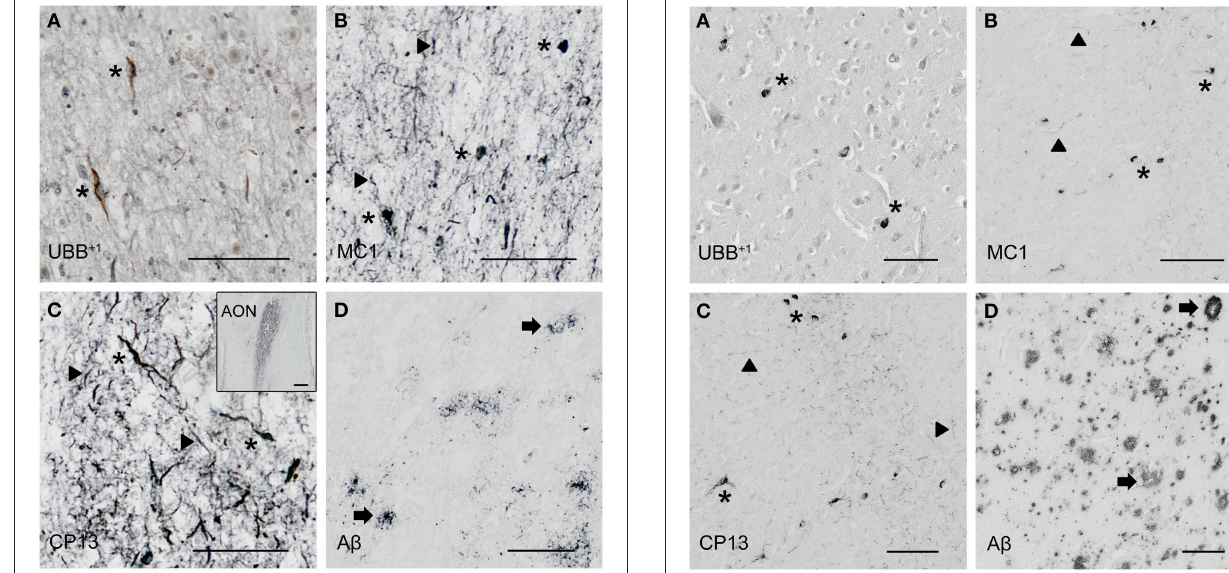
FIGURE 4 | Photomicrographs of UBB + 1 and AD neuropathology (NFTs, NTs, and A β plaques) in the human piriform (Pir) cortex adjacent to the OB of patient #5 (Braak 5). (A–D) shows the olfactory tissue incubated with antibodies against (A) UBB + 1 , (B) pre-tangles (MC1), (C) tangles (CP13), and (D) A β plaques. Asterisk shows intracellular accumulations, represented by neuronal staining. (A) The presence of UBB + 1 in the neuronal cells (asterisk) of the Pir. (B,C) Pir expresses misfolded tau in pretangles and NFTs (asterisk) . NTs are shown by filled triangles . (D) Abundant present of A β plaque formation (arrow) in the Pir. Bars: (A–D) , 100 µ m.